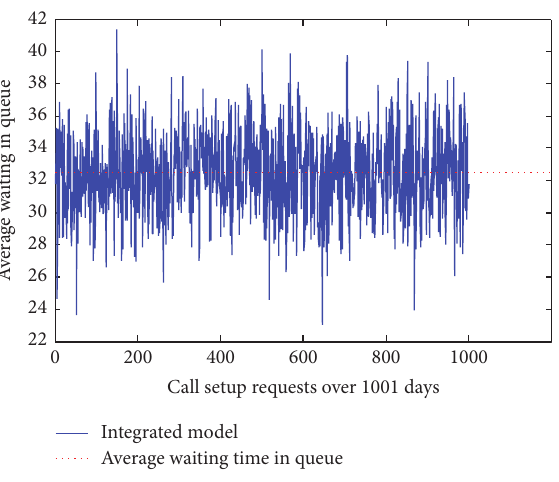
Figure 3: Waiting time in queue over 1001 days.